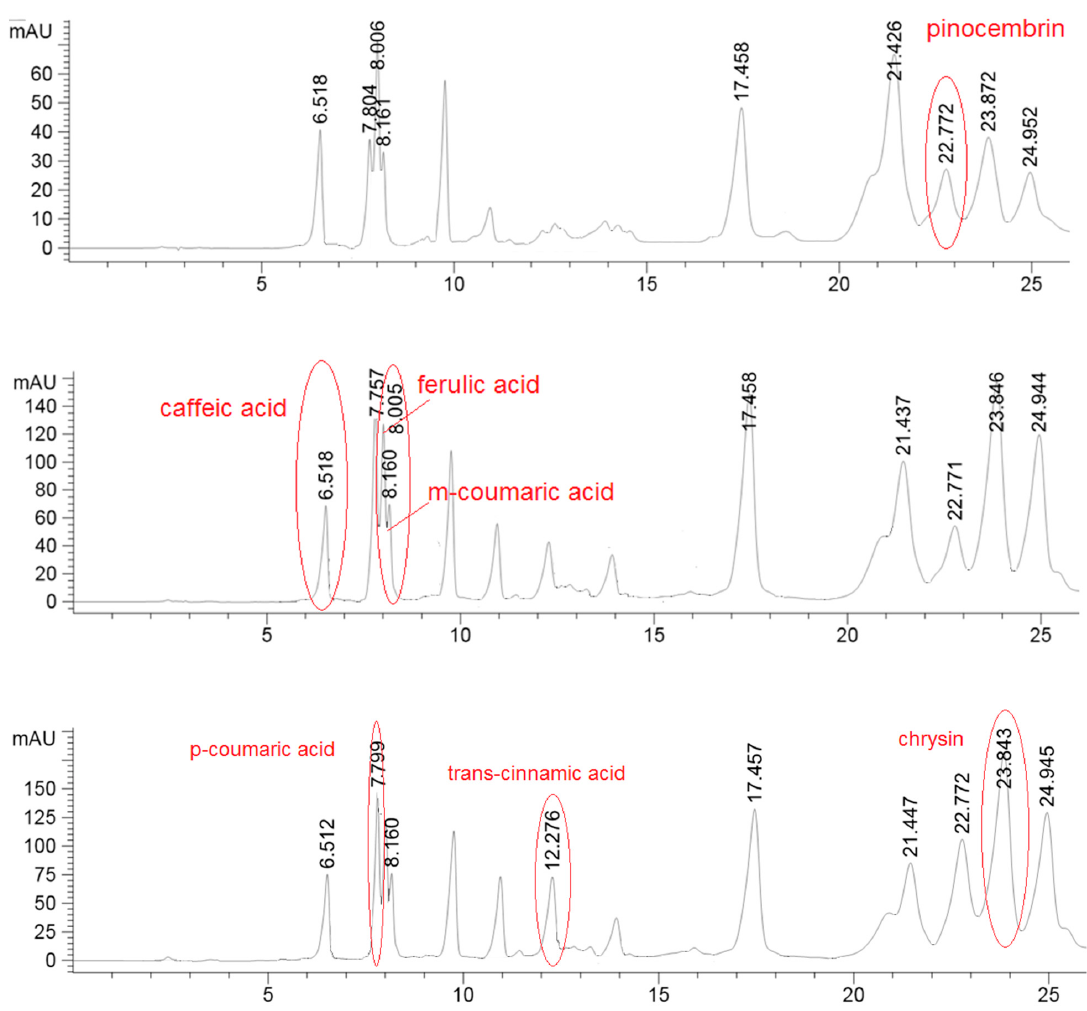
Figure 1. Detection of pinocembrin in one hills sample at 375 nm; detection of caffeic acid, ferulic acid and m -coumaric acid in one hills sample at 325 nm; detection of p -coumaric acid, trans -cinnamic acid and chrysin in one hills sample at 295 nm.